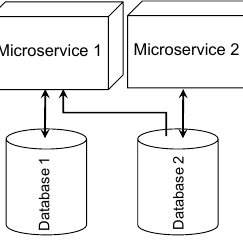
Figure 2. Shared persistency.